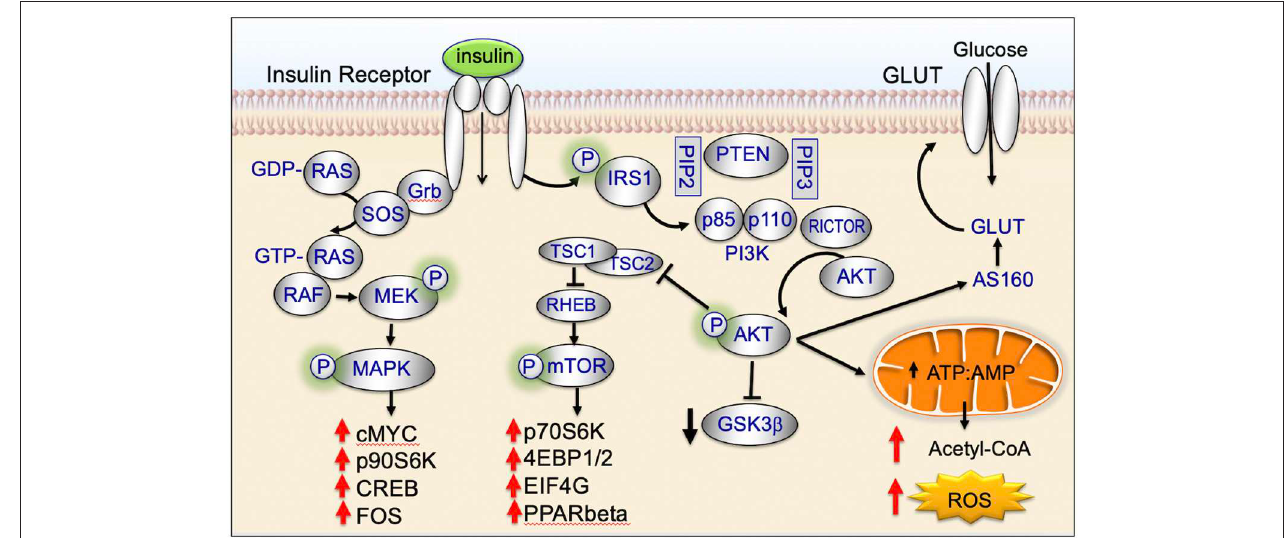
FIGURE 2 | Insulin signaling, glucose uptake, and cancer